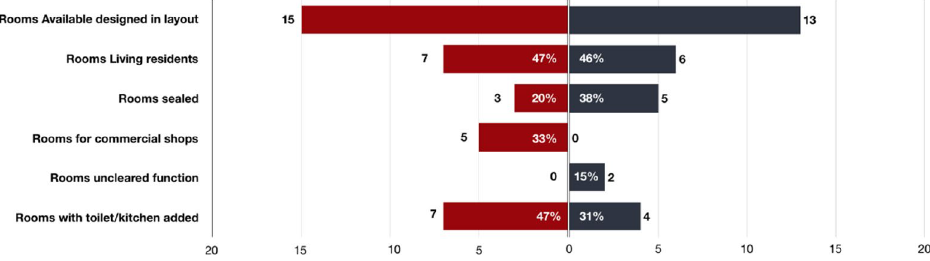
Figure 6. Spatial analysis of rooms in the case study building ZF 84 (Red for 1st floor; Black for 2nd floor).